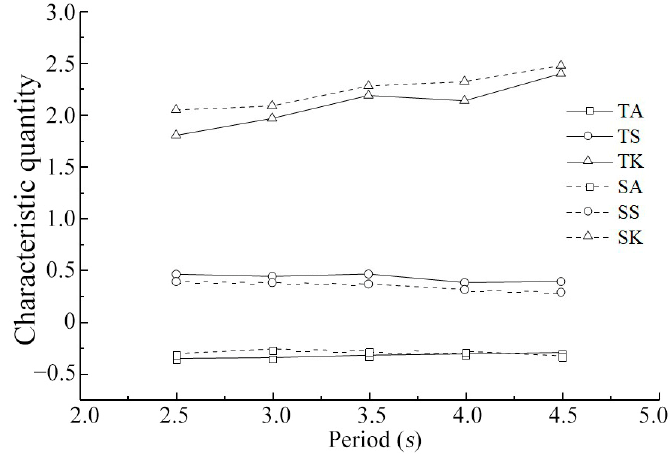
Figure 10. Distribution of nonlinear characteristic quantities with wave height.